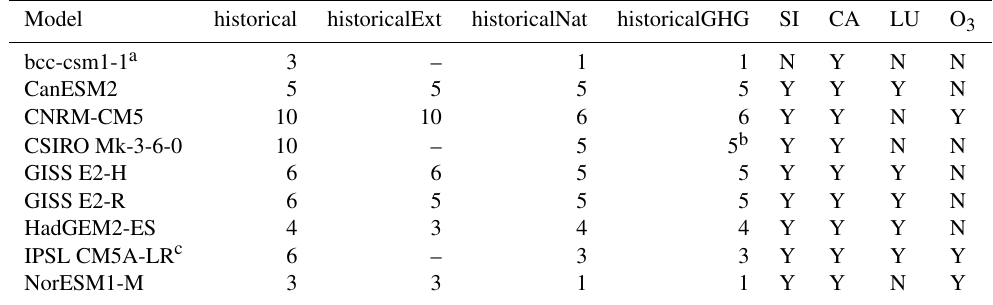
Table 1. CMIP5 models. The number of ensemble members for each model and experiment. We did not use ensemble members derived from perturbed physics simulations. All models include volcanic aerosol influences. SI – sulfate indirect effects (first and/or second effects), CA – carbonaceous aerosols (black and organic carbon), LU – anthropogenic land use changes in the historical experiment, O 3 – ozone influences in the historicalGHG